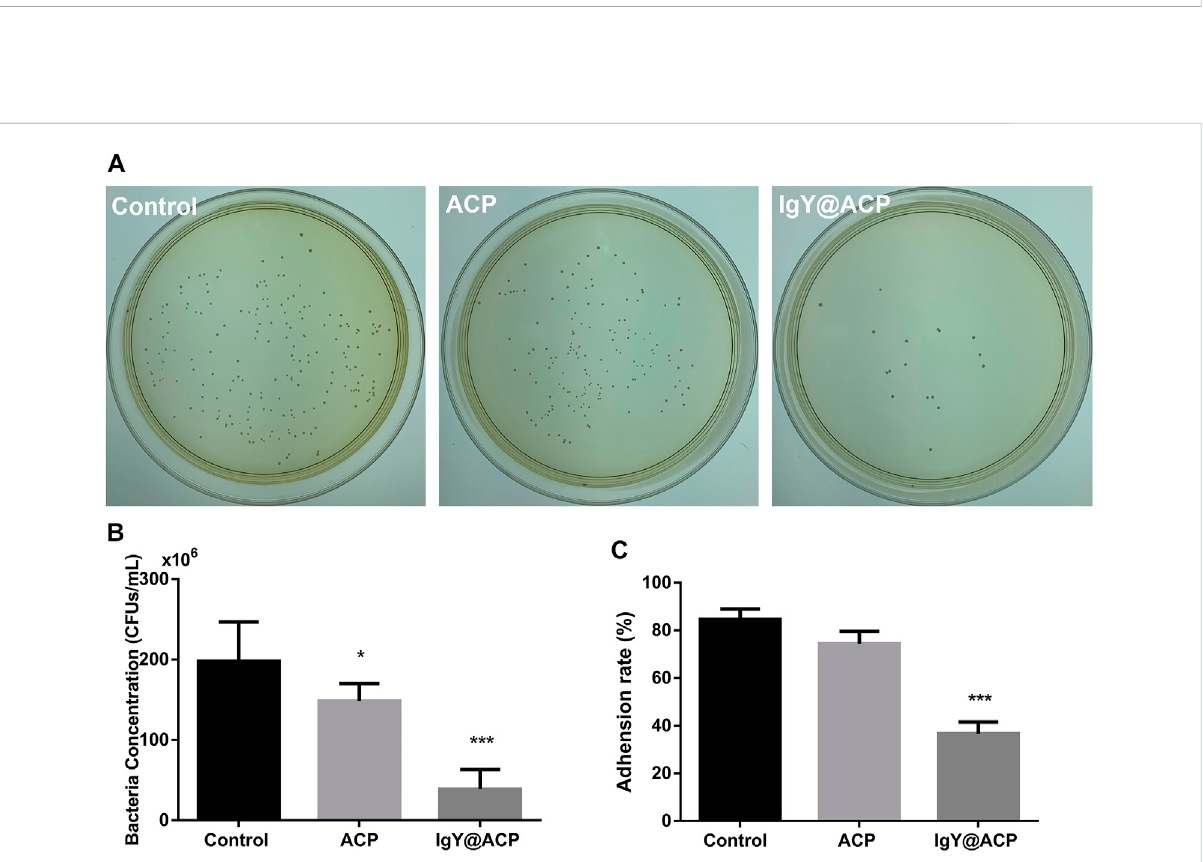
FIGURE 8 Theantibacterial effectsofIgY@ACPagainstplanktonic S.mutans onCFU counting (A,B) andadhesionrate (C) .Thesigni fi cancelevelwassetat * p < 0.05, ** p < 0.01, and *** p <